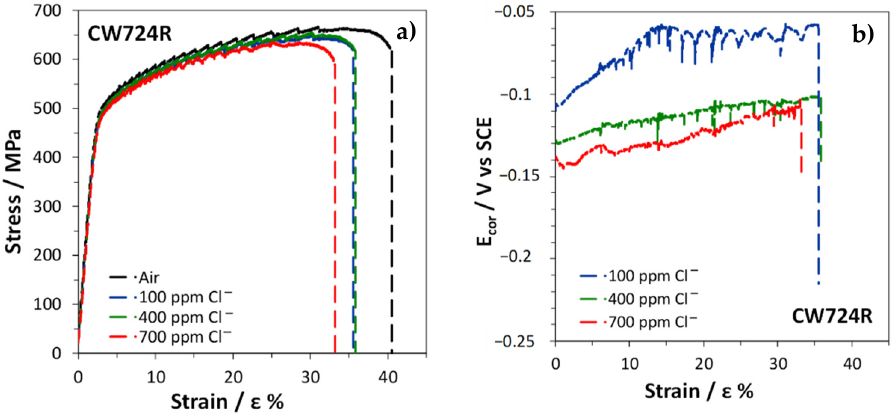
Figure 18. SSRT on CW724R: ( a ) stress vs. strain curves obtained in air and in SDW solutions and ( b ) E cor values recorded in SDW solutions.